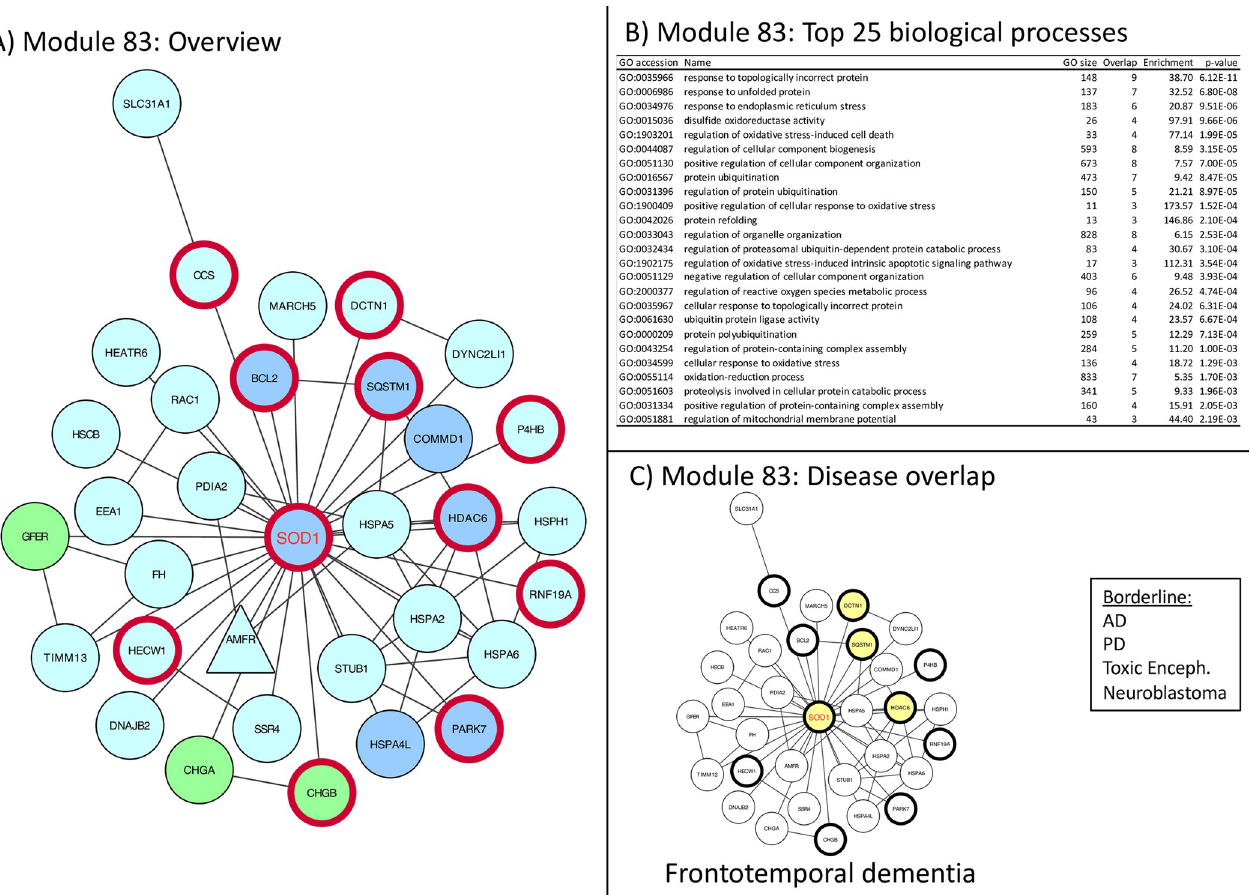
Fig 5. Module 83 –Protein folding and oxidative stress. Panel A: thick red border: gene/protein annotated to be ALS-associated on any of the 7 lists. Large red label: gene/protein with GWAS evidence. Triangular shaped nodes: receptors (UniProt keyword). Node colors indicate subcellular location (UniProt keywords): Blue = Nuclear, Green = Secreted, Purple = conflicting nuclear/secreted, cyan = neither nuclear nor secreted (likely cytosolic). Panel B: Gene Ontology overrepresentation analysis. Panel C: Thick border: ALS-associated (as panel A), Colored node: Disease-associated gene/protein.